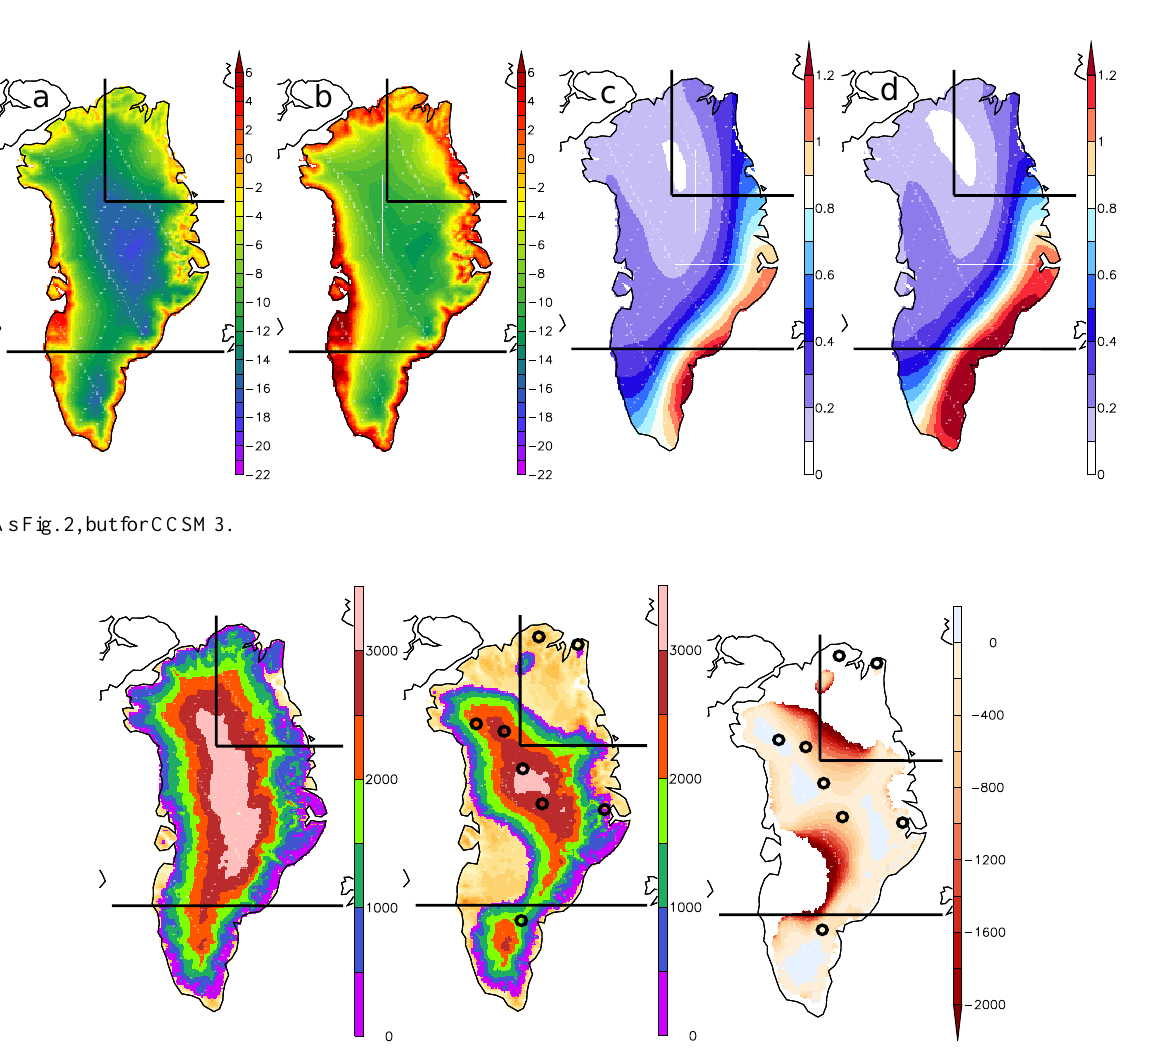
Fig. 5. Modelled ice thickness (in m) after 10000yr of simulation with preindustrial forcing (left) and after 6000yr with 126ka forcing (middle). Difference in ice thickness 126ka–0ka (right). Regions defined for this study are separated by bold black lines. Circles show locations of ice core sites (from north to south: Hans Tausen Iskappe, Flade Isblink, Camp Century, NEEM, NGRIP, GRIP, Renland, Dye-3). Preindustrial ice area and thickness are well reproduced. With 126ka forcing, the Greenland ice sheet melts mostly from the northeast and southwest. The southern dome does not disappear.